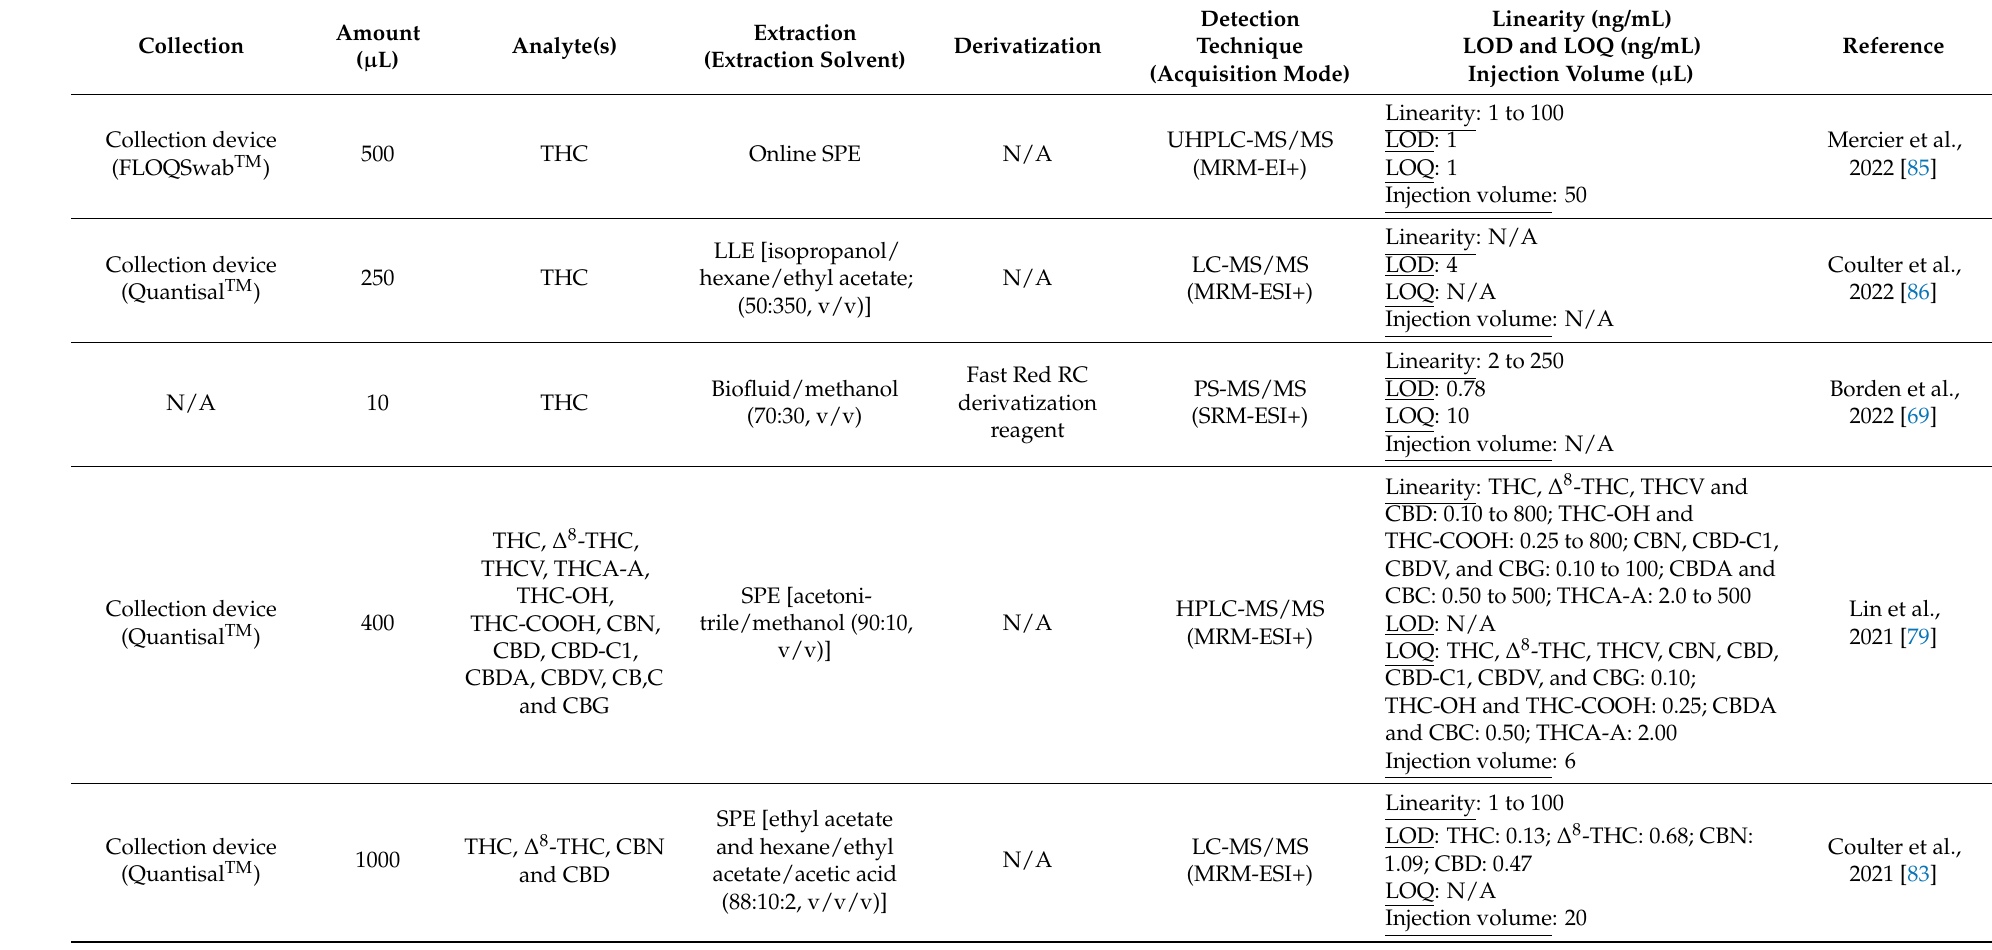
Table 4. Methods for the identification and quantification of cannabinoids in